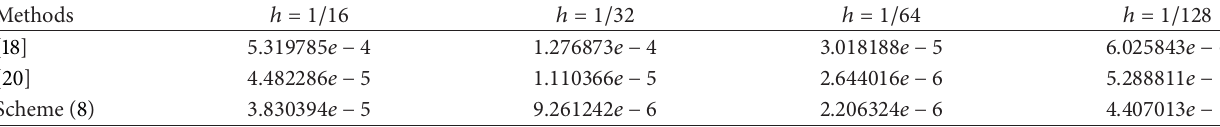
Table 3: The maximal errors of numerical solutions at 𝑡 = 10 , 𝜏 = 0.1 , 𝛽 = 1 , 𝛼 = 2 , and 𝑝 = 8 .